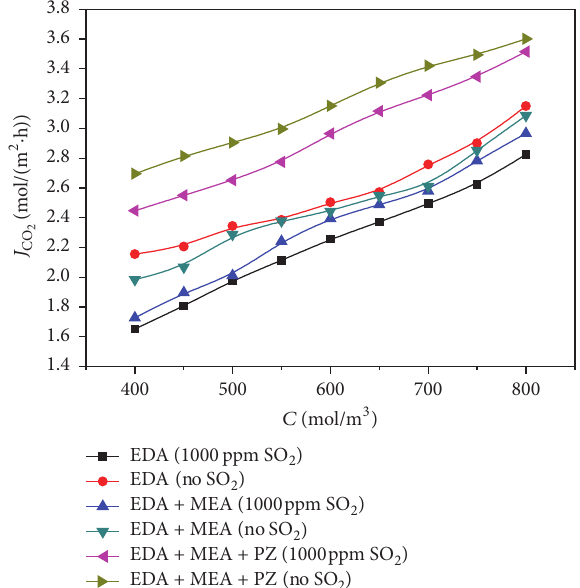
Figure 8: Influence of SO 2 on the CO 2 mass transfer rate in different concentrations of absorbent ( 𝑈 𝑔 = 4m 3 /h, U 288